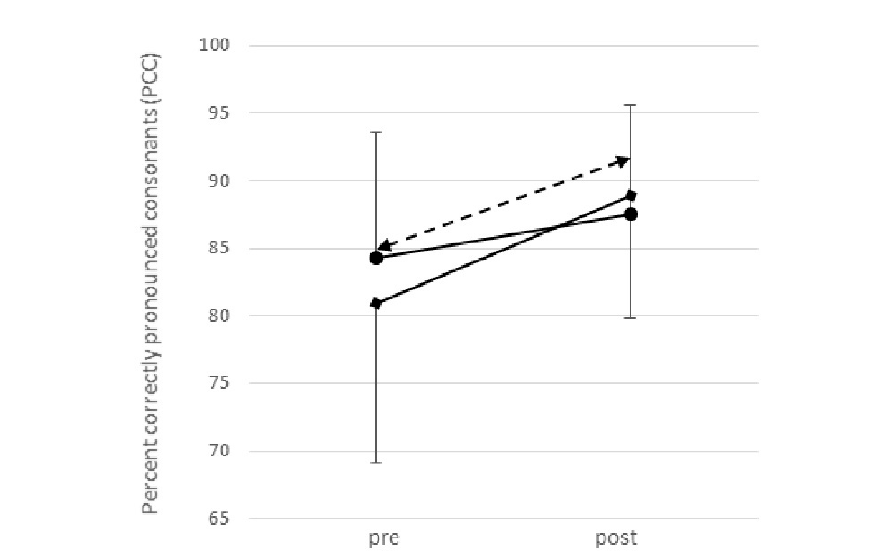
Figure 2. Change in percent correctly pronounced consonants (PCC) from time point To to T1, for the mean of the treatment group and the wait-list control group (solid lines). Change of PCC scores from time point T1 to T2 for the wait-list control group after their treatment phase following the waiting phase is shown as dashed line.